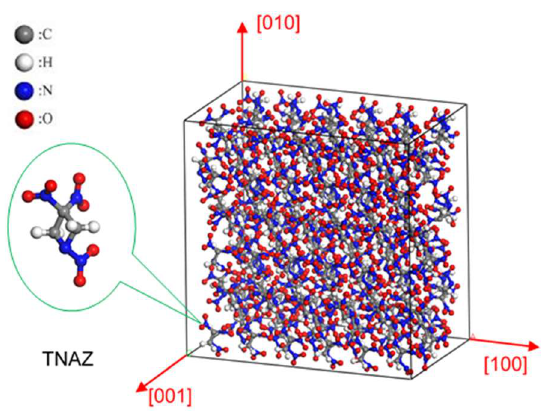
Figure 1. Schematic diagram of the TNAZ molecular